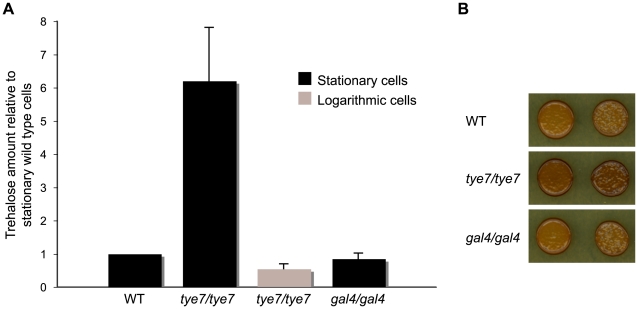
Deletion of TYE7 results in higher trehalose and glycogen levels.(A) The trehalose content of wild type (BWP17), tye7, and gal4 cells at both stationary and logarithmic phases were measured. Trehalose levels (nmol trehalose per mg cell protein) were reported relative to the wild type in stationary phase. Both wild type and gal4 cells had no detectable trehalose levels in the logarithmic phase and were not included in the graph. (B) Wild type (BWP17), tye7, and gal4 cells were exposed to iodine vapor to indicate the glycogen content as iodine vapor stains cells brown upon reacting with glycogen. The tye7 cells stained a darker brown than the wild type indicating that there is more glycogen present.